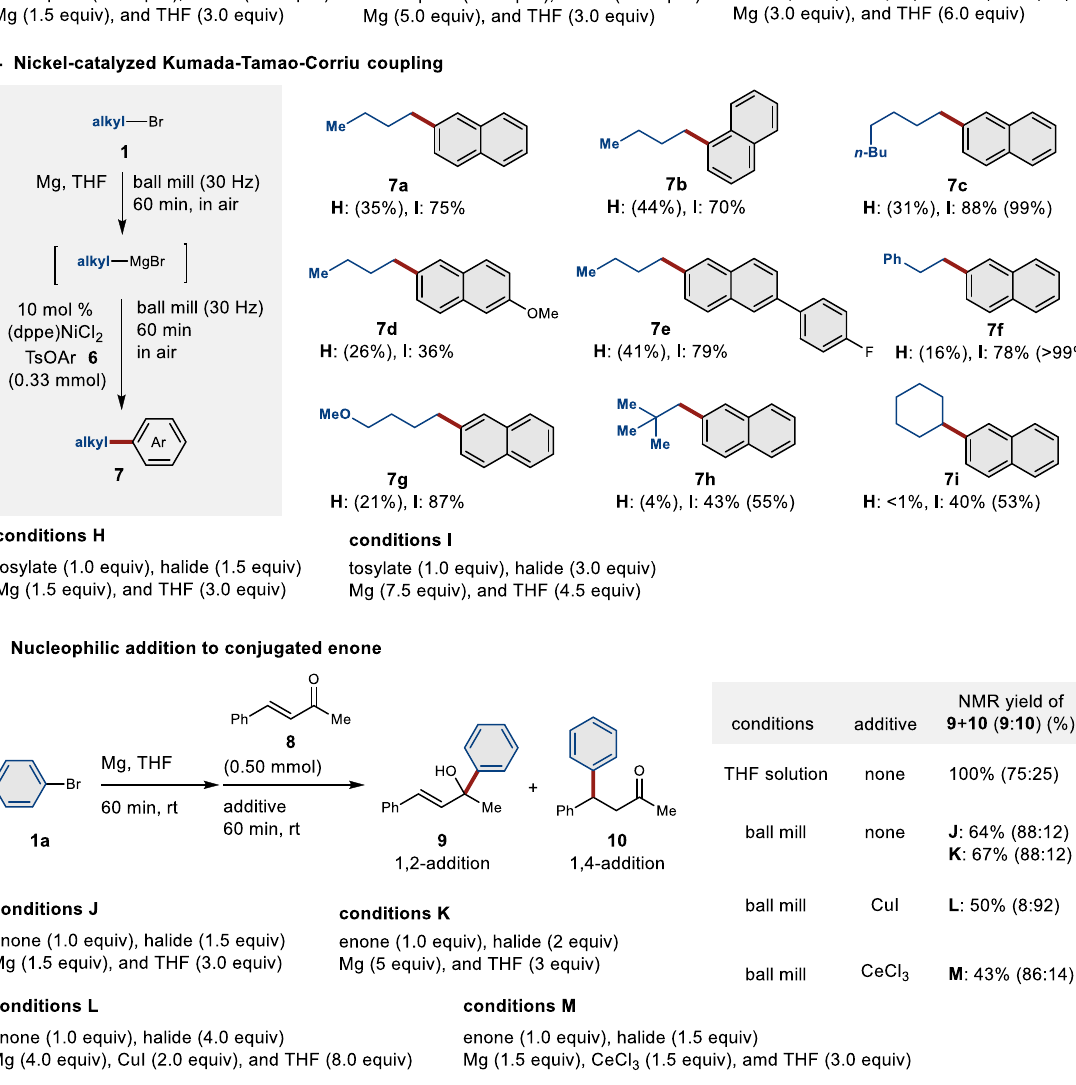
Fig. 4 Various organic transformations using mechanochemically generated organomagnesium nucleophiles. Isolated yields are reported as percentages. Proton NMR integrated yields are shown in parentheses. a Nucleophilic addition to various electrophiles under mechanochemical conditions. b Mechanochemical nickel-catalyzed Kumada – Tamao – Corriu coupling reactions. c Nucleophilic addition reactions to conjugated enone 8 under mechanochemical conditions. A stainless-steel milling jar (5mL) and a stainless-steel ball (diameter: 10mm) were used. For details, see the Supplementary Information.